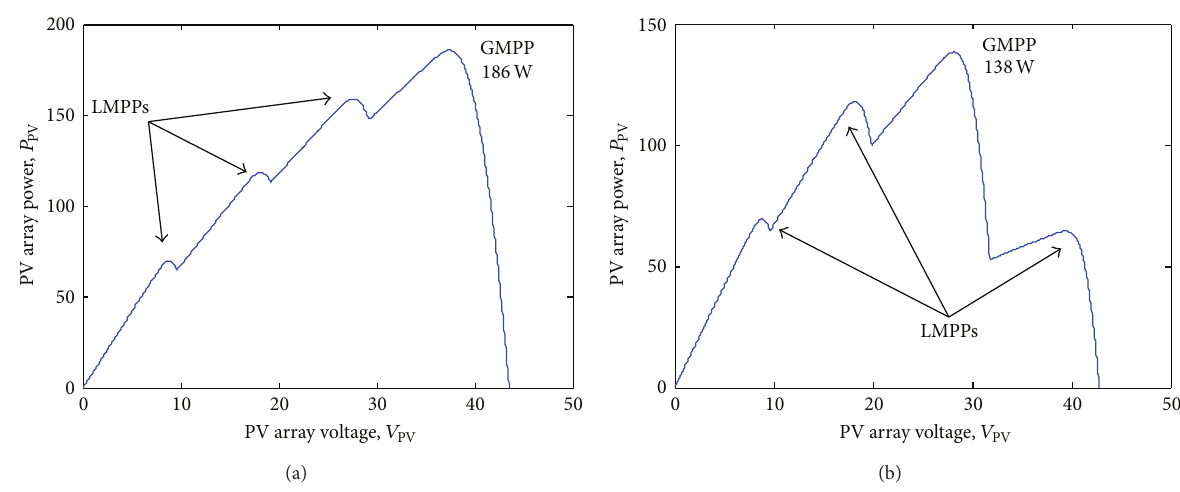
Figure 5: 𝑃 - 𝑉 curves for PV array under partial shading, solar intensity are (a) 1.0kW/m 2 , 0.8 kW/m 2 , 0.7 kW/m 2 , and 0.6 kW/m 2 and (b) 1.0kW/m 2 , 0.8 kW/m 2 , 0.2 kW/m 2 , and 0.6 kW/m 2